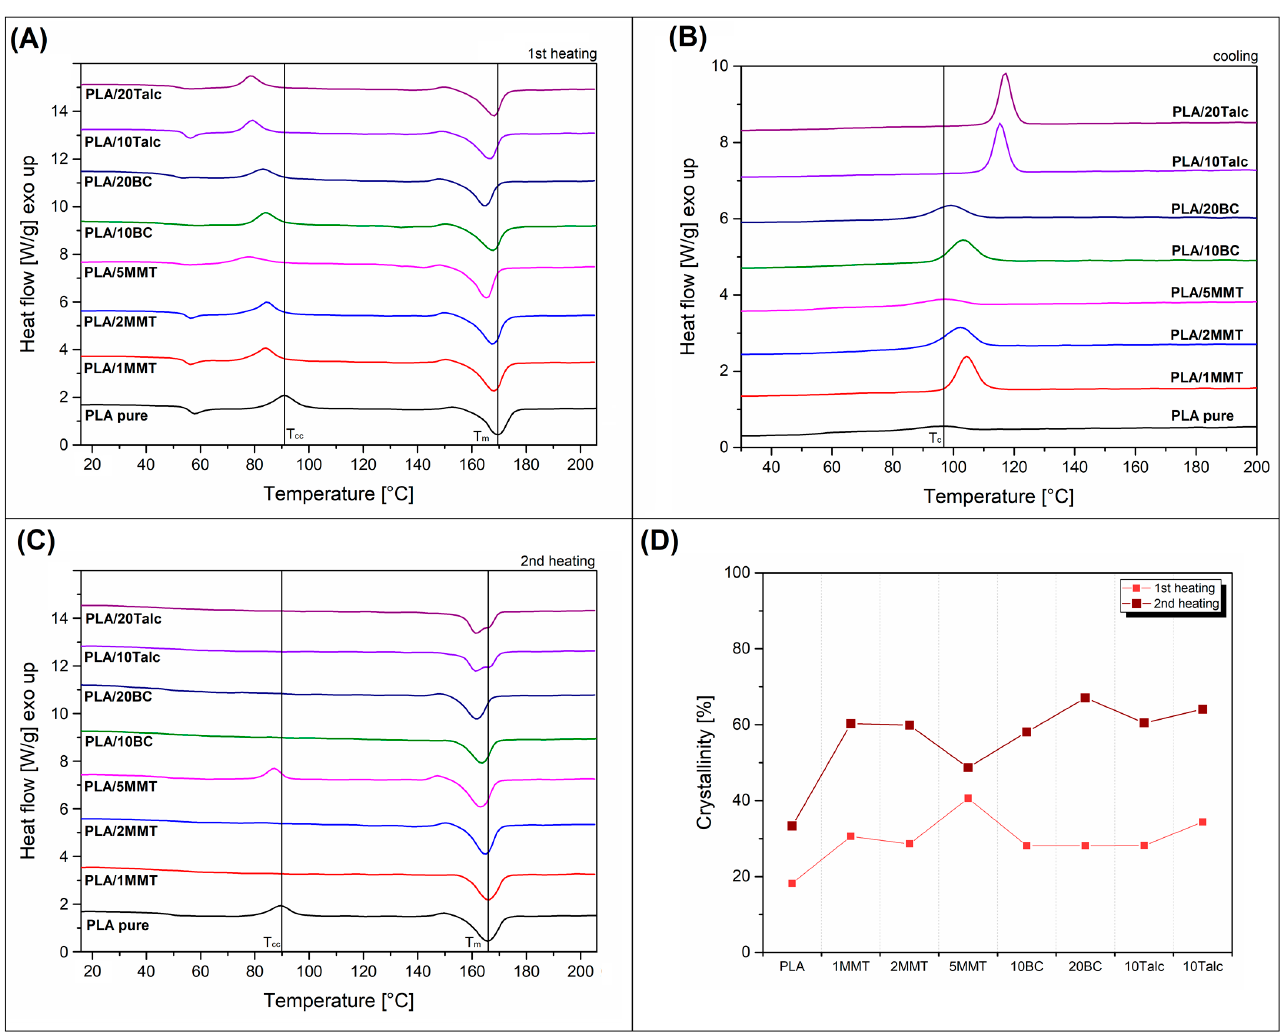
Figure 5. The results of the DSC analysis. ( A ) 1st heating; ( B ) cooling; ( C ) 2nd heating; ( D ) PLA crystallinity.